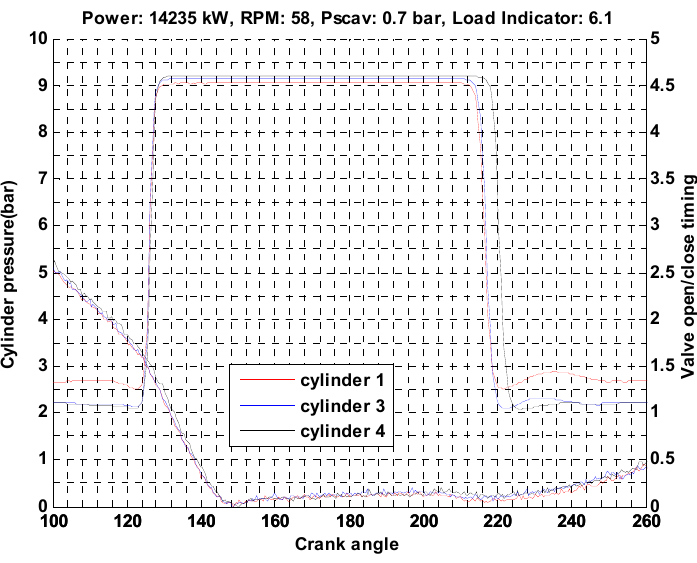
Figure 12. Cylinder pressure with respect to exhaust valve timing vs. crank angle degrees (aTDC).